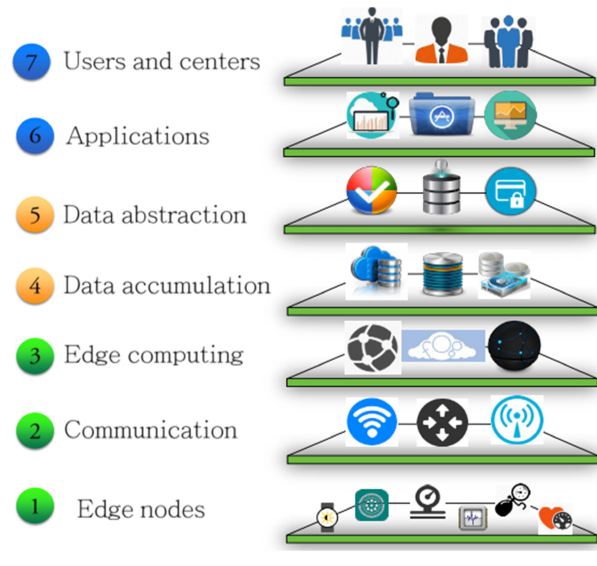
Figure 1. CISCO’s RM [21].